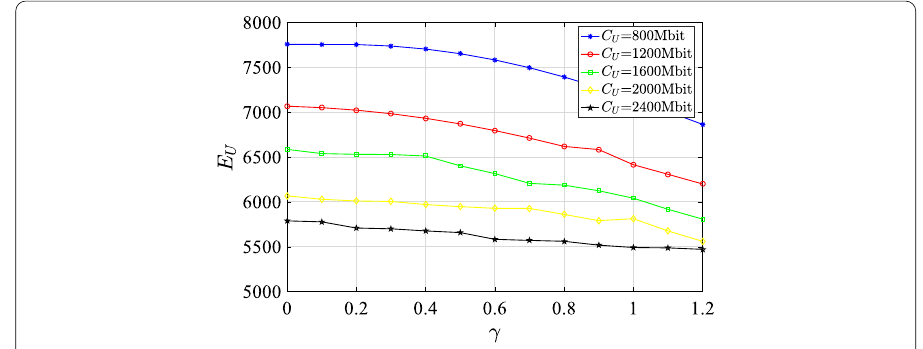
Fig. 8 The effect of γ on E U under different C U